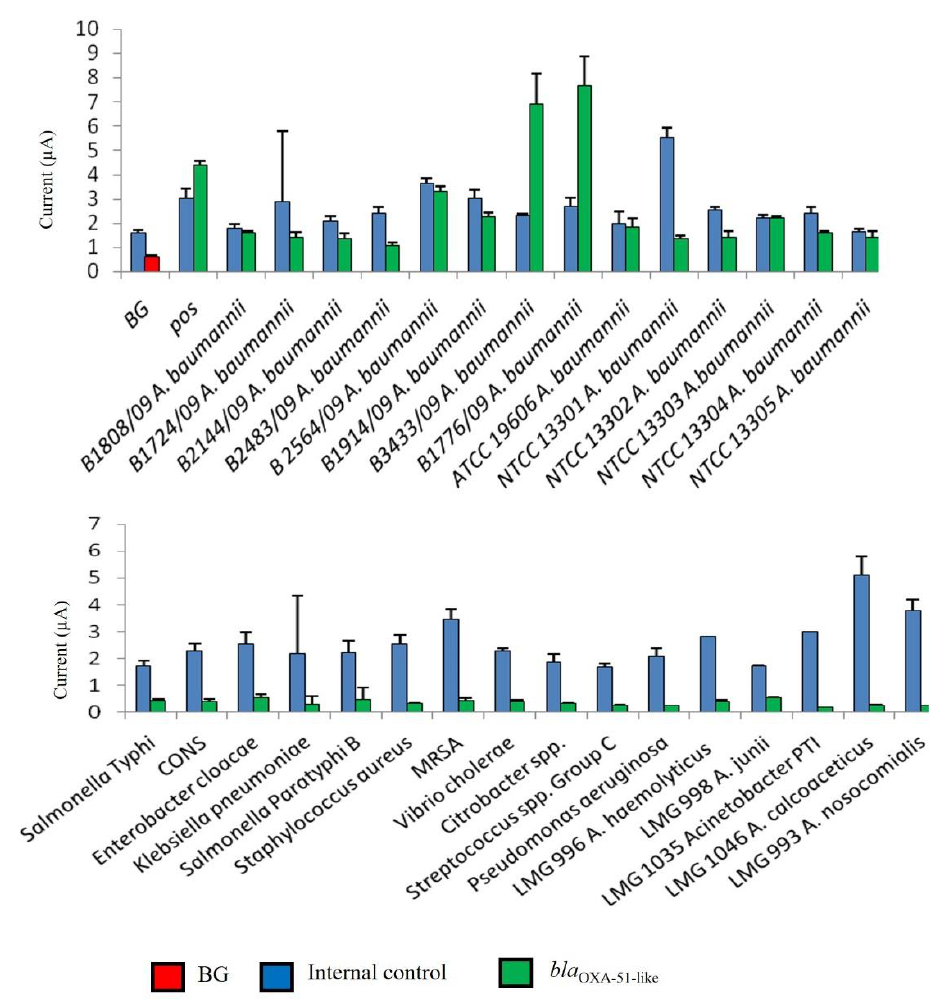
Figure 2. Analytical specificity of an enzyme-based electrochemical DNA biosensor using different bacterial strains. The error bars show the standard deviation for triplicate tests. CoNS — Coagulase- negative Staphylococcus ; MRSA — Methicillin-resistant S. aureus ; BG — background control without using bacterial strains.